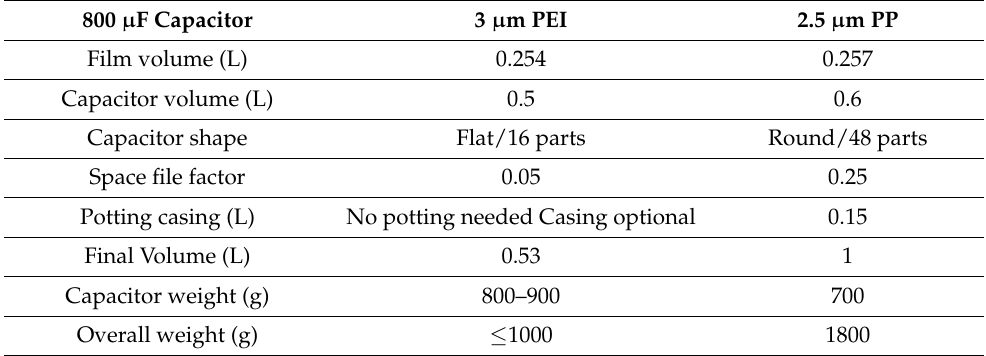
Table 7. Summary of the characteristics of the film capacitor being developed by General Electric